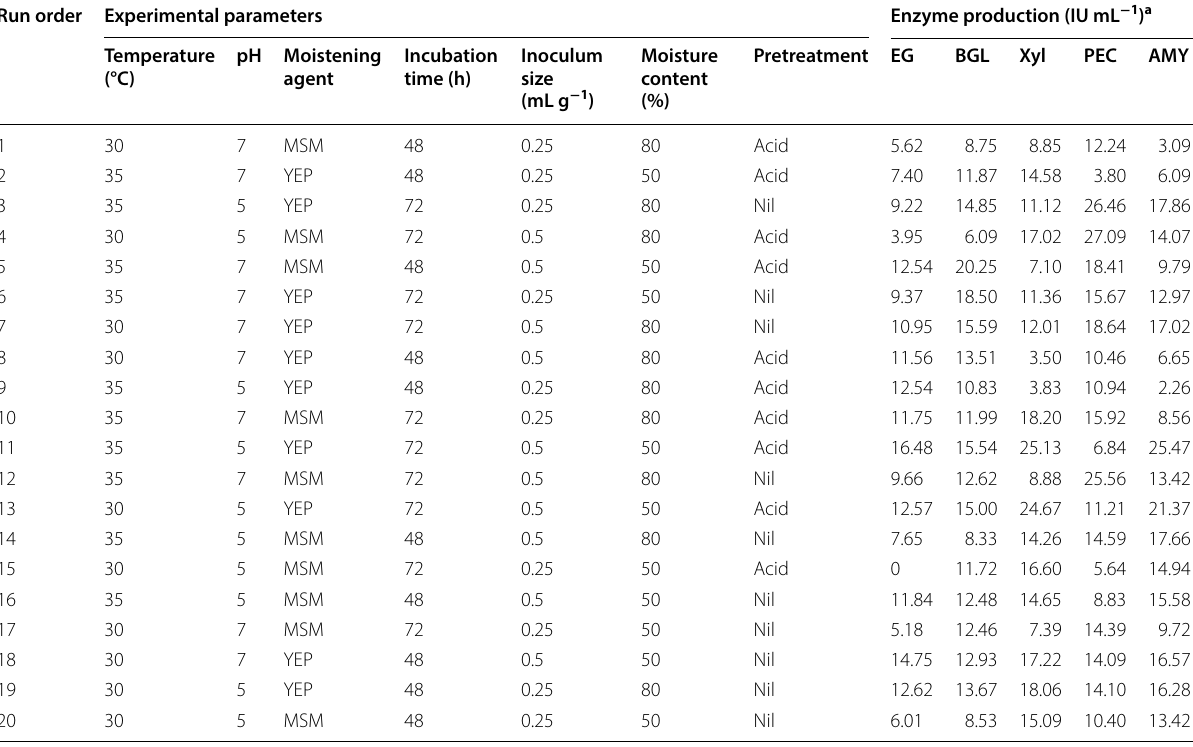
SSF of acid-pretreated Citrus limetta was carried out by yeast consortium, factors affecting multienzyme PREPARATION were adjusted at two levels (temperature 30, 35 °C; pH 5, 7; Moistening agent mineral salt medium or MSM, yeast extract and peptone; incubation time 48, 72 h; inoculum size 0.25, 0.5 mL g − 1 ; moisture content 50, 80%; pretreatment acid, no treatment, or nil), and the production of endoglucanase (EG), β-glucosidase (BGL), xylanase (Xyl), pectinase (PEC), and amylase (AMY) was taken as response a The values represent average of triplicate with insignificant standard